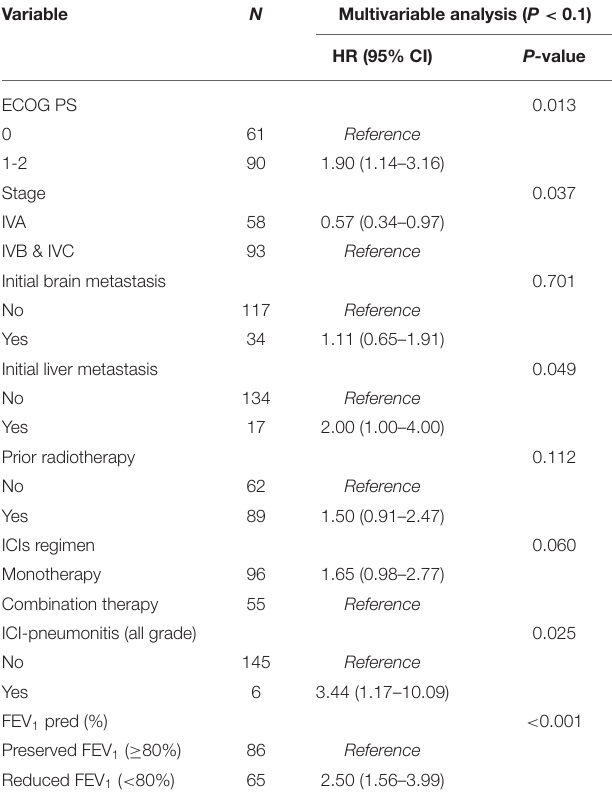
TABLE 3 | Factors associated with overall survival by Cox regression model in all patients received immune checkpoint inhibitors (80% of predicted FEV 1 as a cut-off value of FEV 1